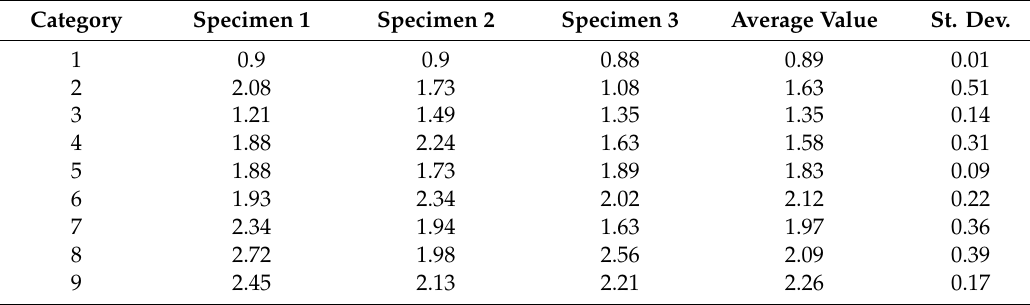
Table 3. Experimental impact energy (J) for the di ff erent